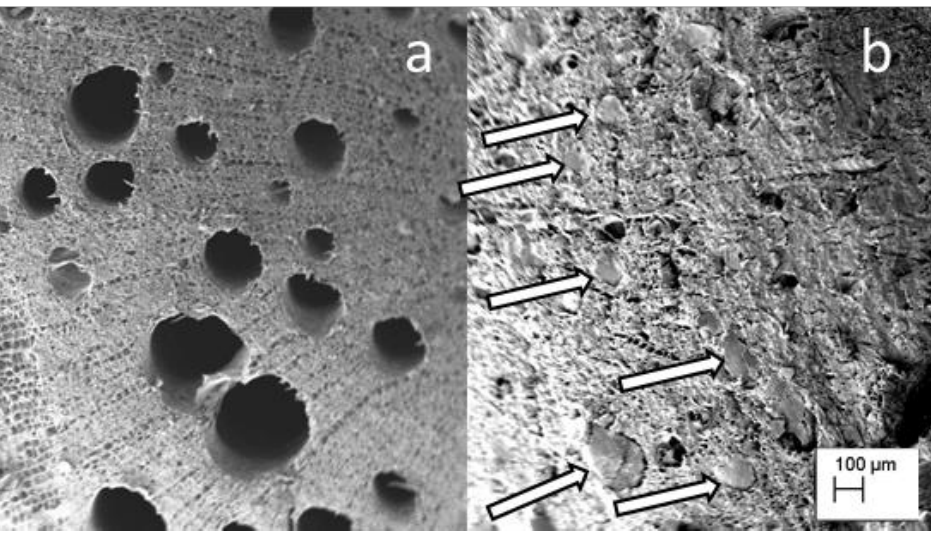
Figure 8. Roots sections observed by scanning electron microscope (SEM); ( a ) — root from a healthy plant (private garden); ( b ) — root from treatment FlCon. Arrows indicate some of the occluded vessels.